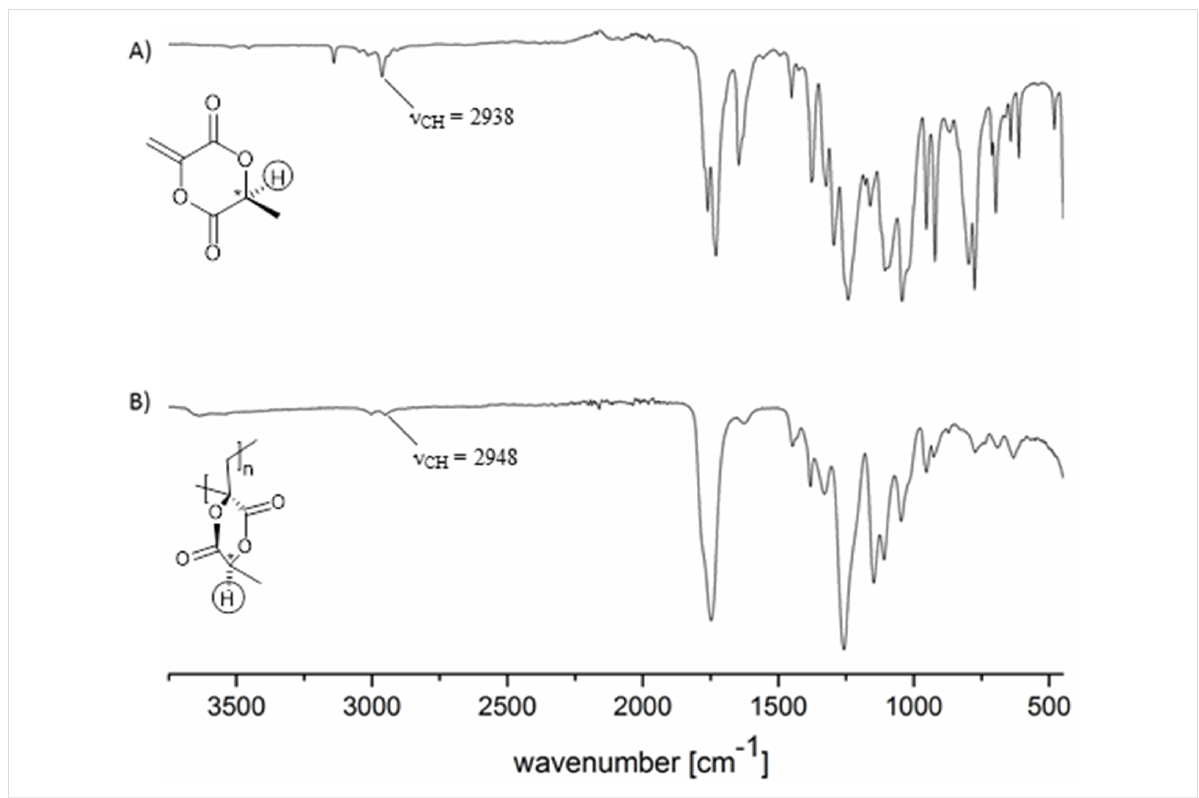
Figure 4: IR spectra of (A) MLA and of (B) poly(MLA) prepared by the self-initiated polymerization at 70 °C.